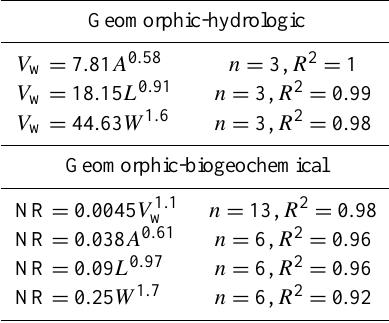
Table 2. List of equations describing geomorphic, hydrologic, and biogeochemical